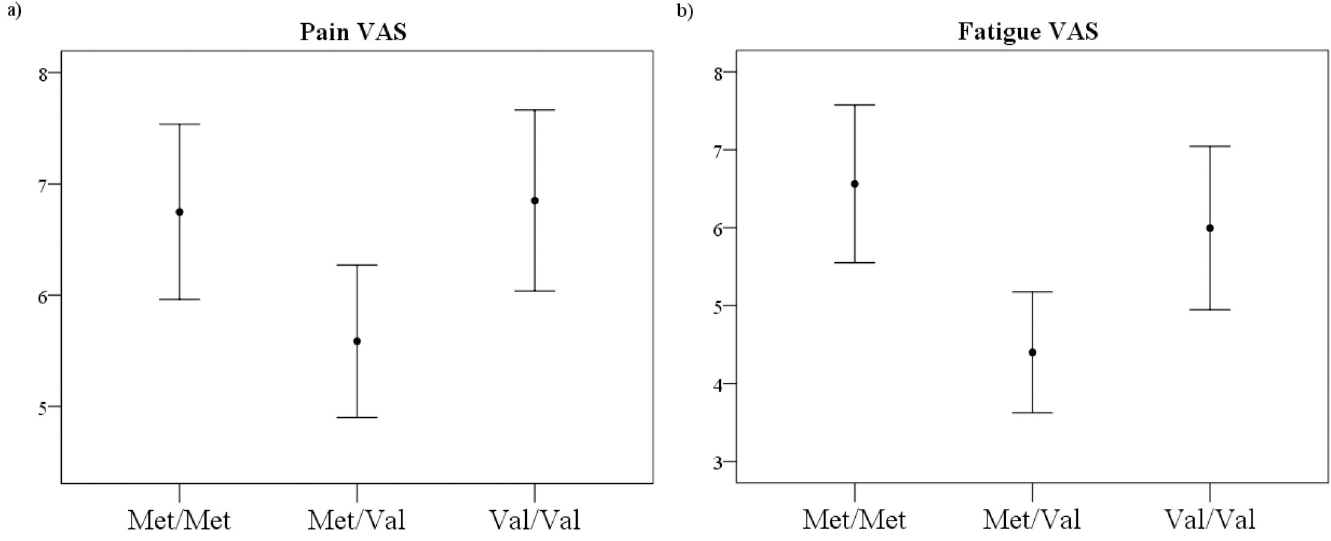
Fig 1. Mean and standard error of VAS pain (A) and VAS fatigue (B) for patients with fibromyalgia.